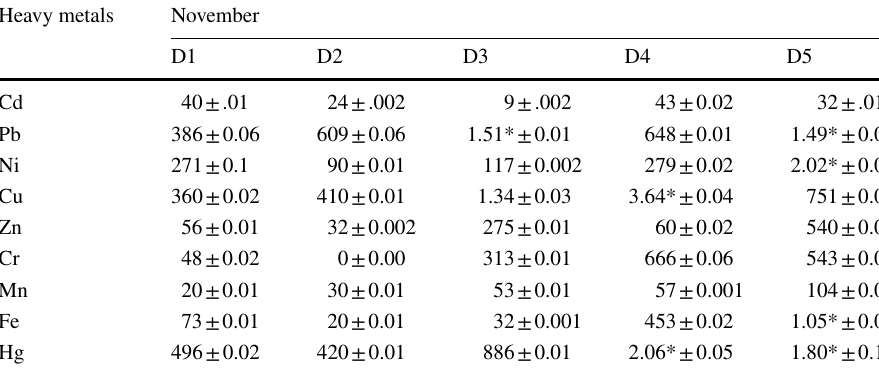
All the heavy metal units are in µg/L; only